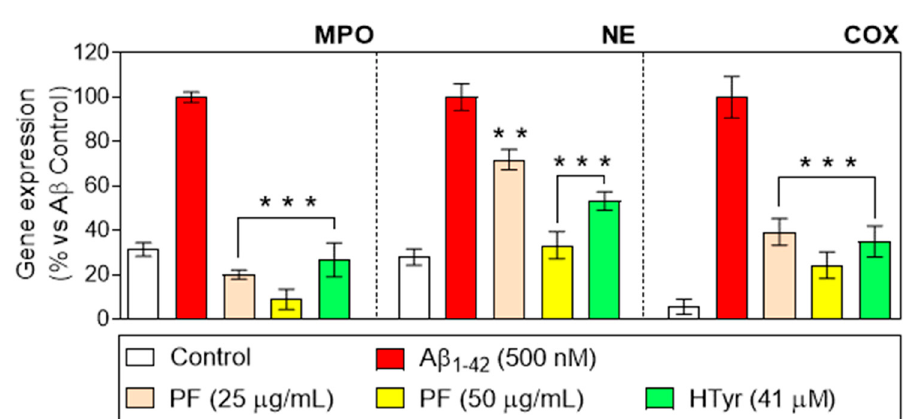
Figure 1. Relative gene expression of myeloperoxidase (MPO), neutrophil elastase (NE), and cyclooxygenase-2 (COX-2) in primary human neutrophils stimulated with A β 1-42 (500 nM), after treatment with the PF from VOO (25 and 50 µ g/mL) or hydroxytyrosol (HTyr, 41 µ M) for 6 h. Values are means of the three independent experiments in triplicate, with their standard errors represented by vertical bars (** p < 0.01; *** p < 0.001 vs. A β 1-42 -treated cells).